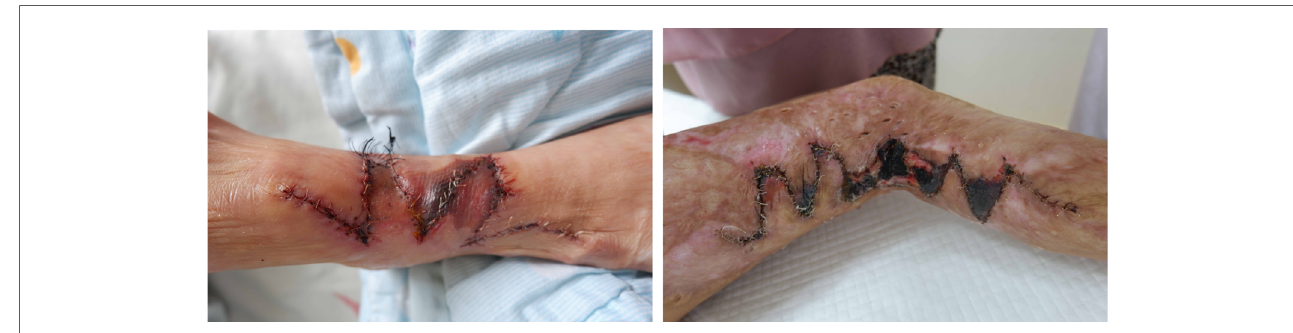
FIGURE 1 Necrosis of the fl ap tip.